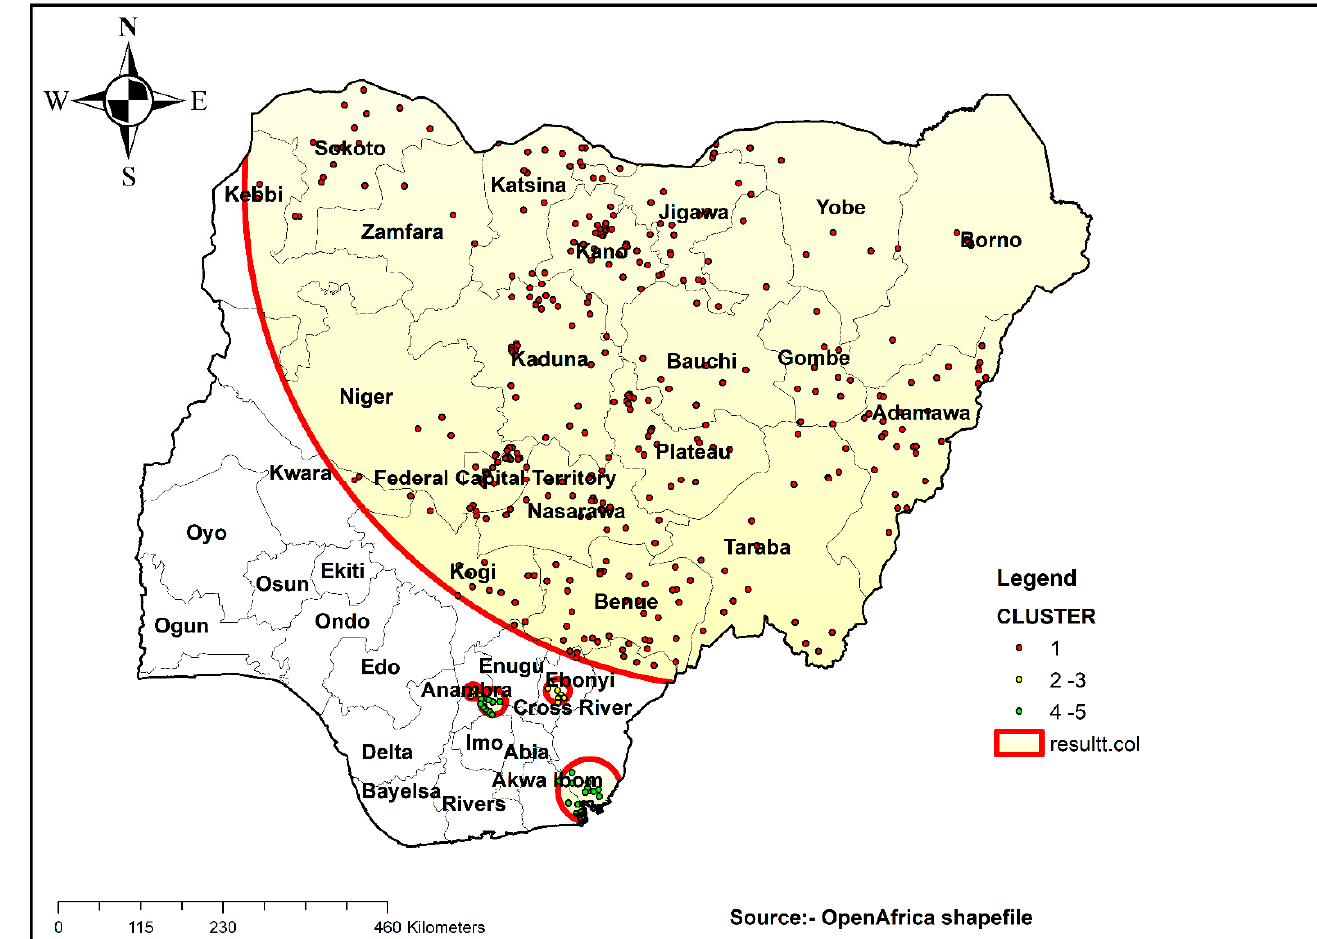
Figure 4. SaTScan analysis result of incomplete ANC visits in Nigeria, 2018.